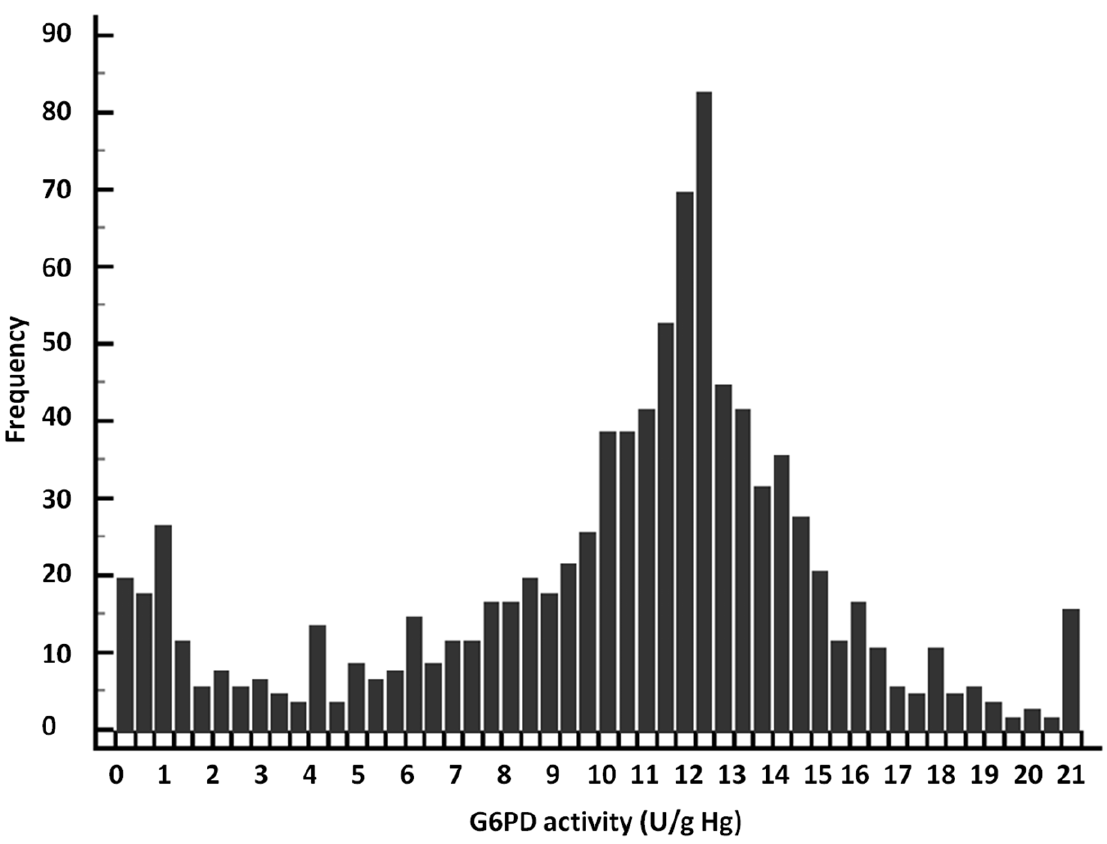
Figure 3. Distribution of the G6PD enzymatic activity (U/g Hb) values of 903 individuals enrolled in four villages of the Pailin province, Cambodia, 2010.